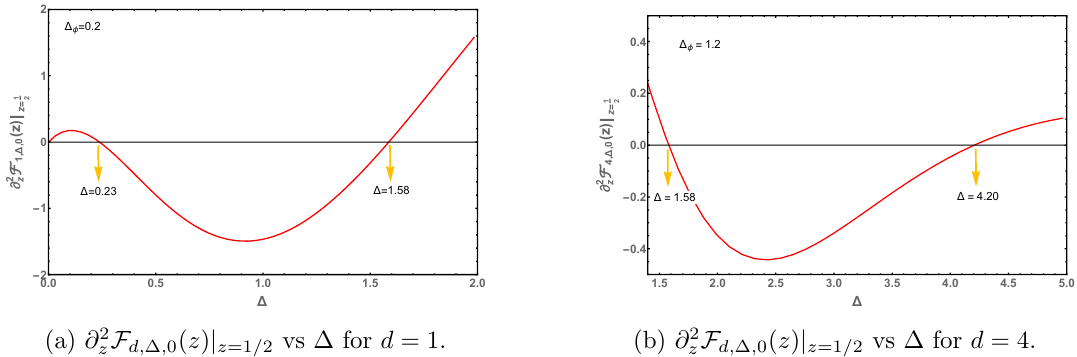
Figure 8. @ 2 F d; (cid:1) ; 0 ( z ) j vs (cid:1). See table 1 and table 4 for values of (cid:1) + and (cid:1) (cid:0) . The indicated z =1 = 2 z values in the plot is exactly matched with the value given in the tables.